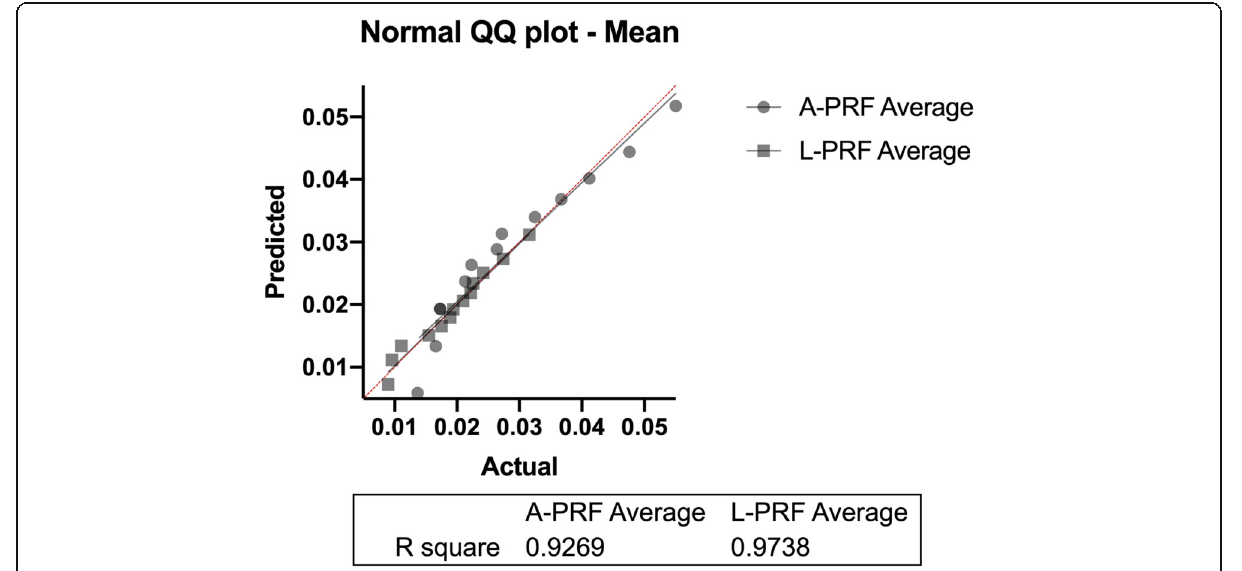
Fig. 3 Normal Q-Q plot. Correlation of the data with the normal distribution